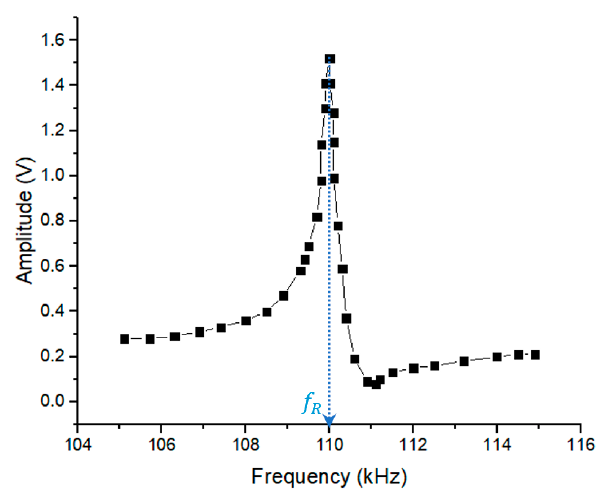
Figure 1. Standard voltage-frequency signal of a magnetoelastic sensor where the resonance peak is clearly seen.